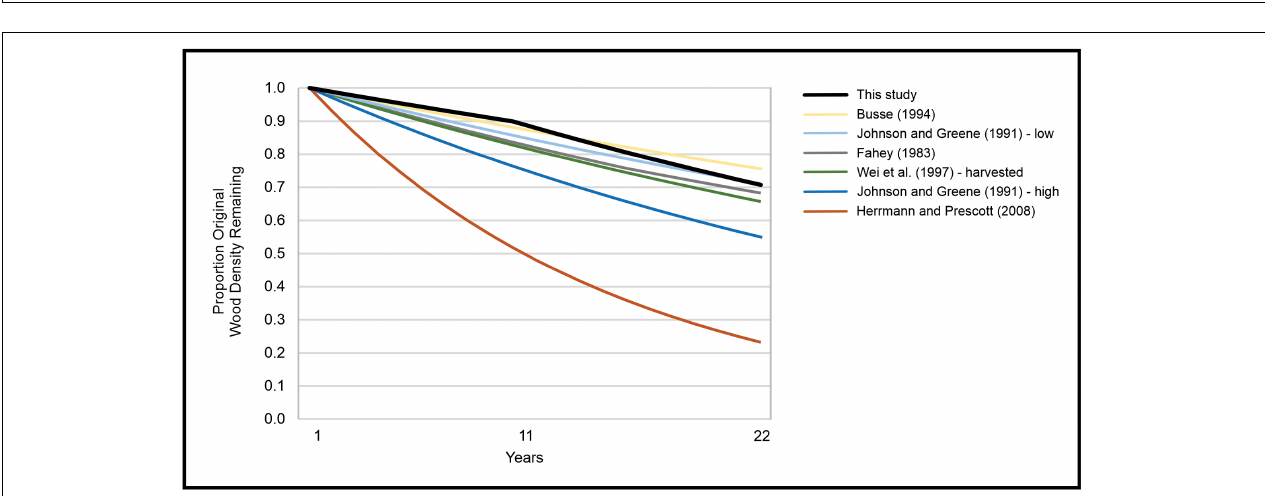
FIGURE 2 | A sample being collected from a log suspended by branches and vegetation in Yr11. Many logs initially suspended were subsequently in contact with the forest floor due to the decomposition of supporting structures and snow load.